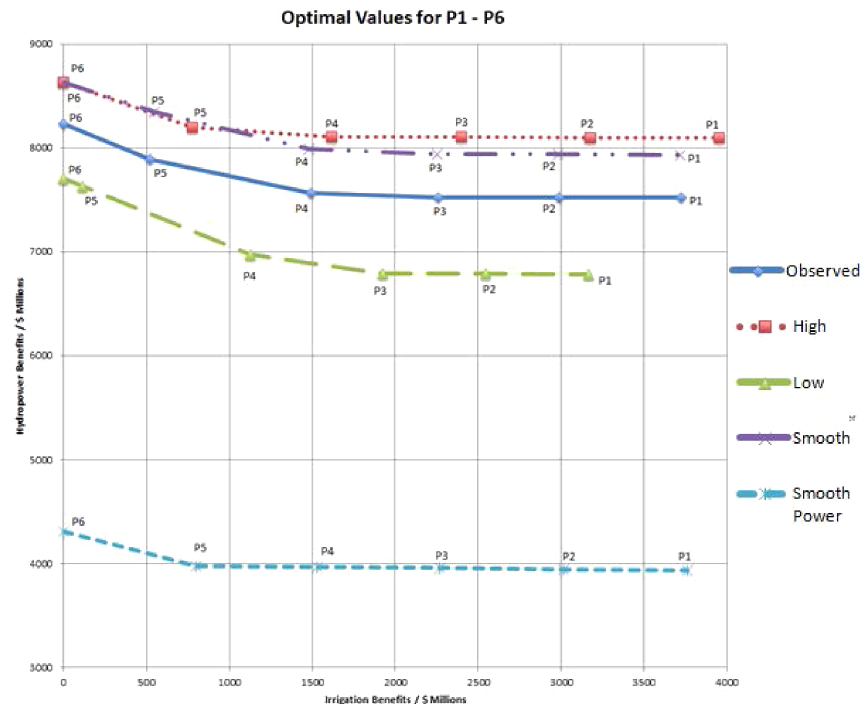
tices. Figure 9 considers a shift in management practices